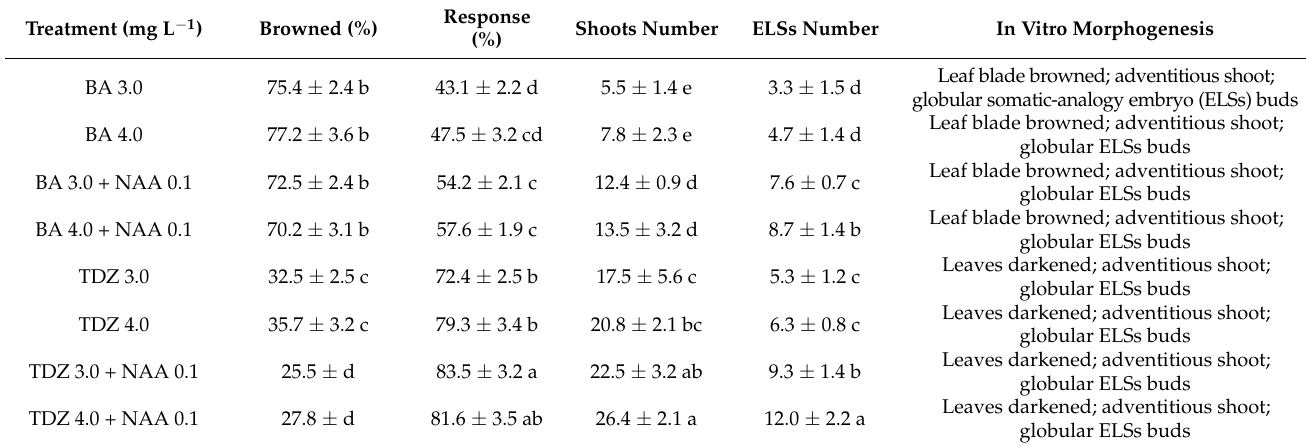
Data are presented as means ± standard deviations from three replicates with 30 explants in each replicate. Different letters within a column indicate significant differences according to Duncan’s multiple range test ( p < 0.05).